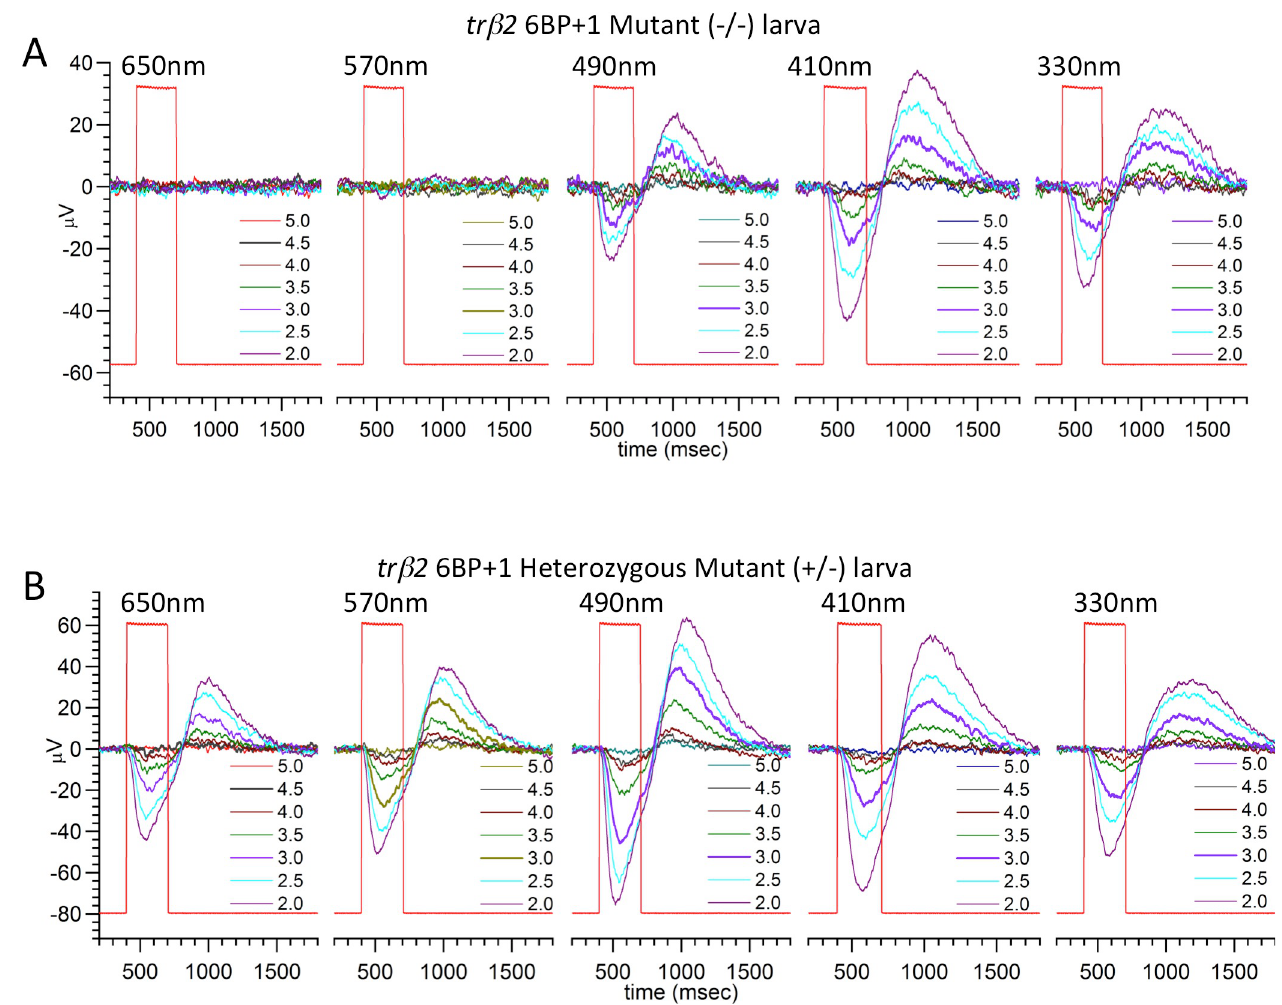
Fig 6. 6BP+1 larval cone PIII ERG spectral response traces. (A) The 6BP+1 mutant does not respond to 650 nm and 570 nm while maintaining a response to shorter wavelengths (N = 12, 70-point datasets). (B) The heterozygote shows sustained responses across all wavelengths (650–330 nm) (N = 16, 70-point datasets). Only half of the spectral dataset is shown in A and B. Wavelength brightness is given in log units of stimulus attenuation, with 5.0 log units being the dimmest stimulus corresponding to the lowest amplitude response, and 2.0 log units being the brightest stimulus corresponding to the largest amplitude response. Larvae are 5 dpf. Cone PIII responses are isolated with 20 mM Na